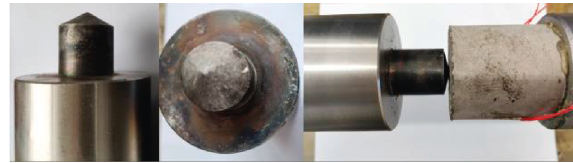
Figure 2: Dynamic point load test bar and sample